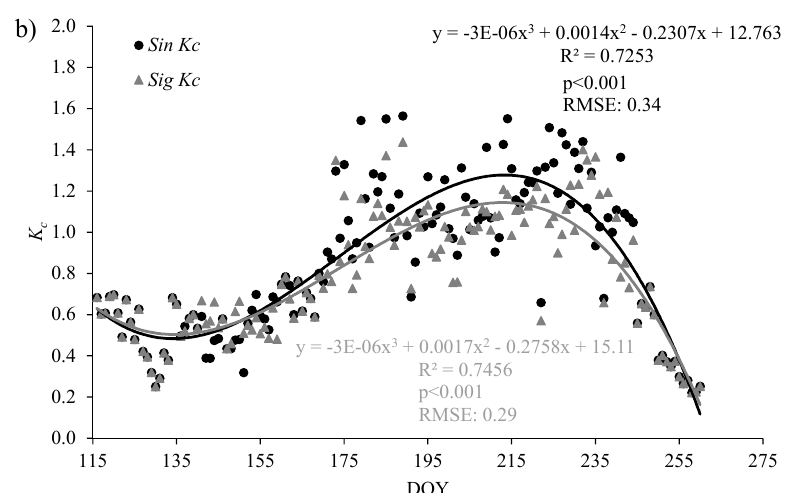
Figure 11. ( a , b ) Seasonal variation in reference evapotranspiration ( ET 0 ) based on crop coefficients ( K c ) for two soybean varieties, Sinara ( Sin ) and Sigalia ( Sig ), during 2017 (a) and 2018 (b) at Keszthely, Hungary.